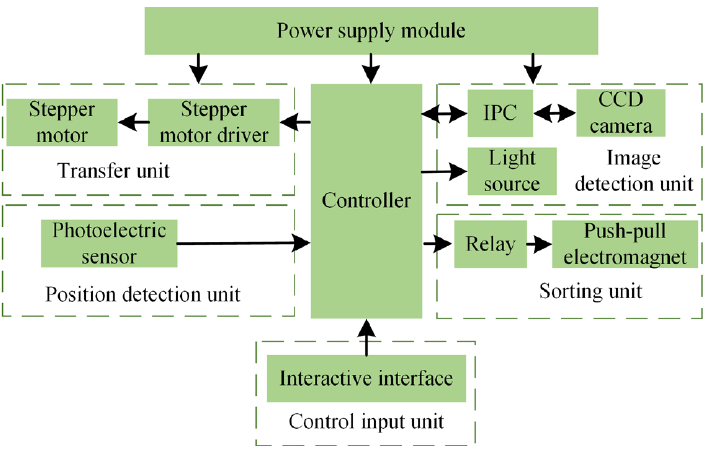
Figure 10. The composition of the hardware system.